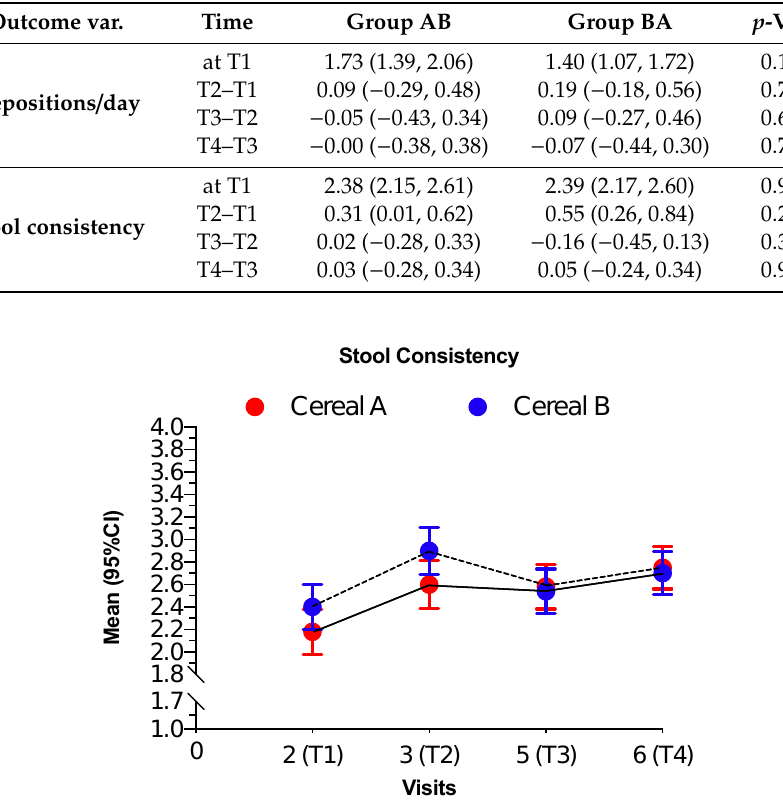
Table 5. Changes in bowel habits variables (depositions / day, stool consistency) between visits. T1: Initiation of first cereal, T2: Follow-up of first cereal, T3: Initiation of second cereal, T4: Follow-up of